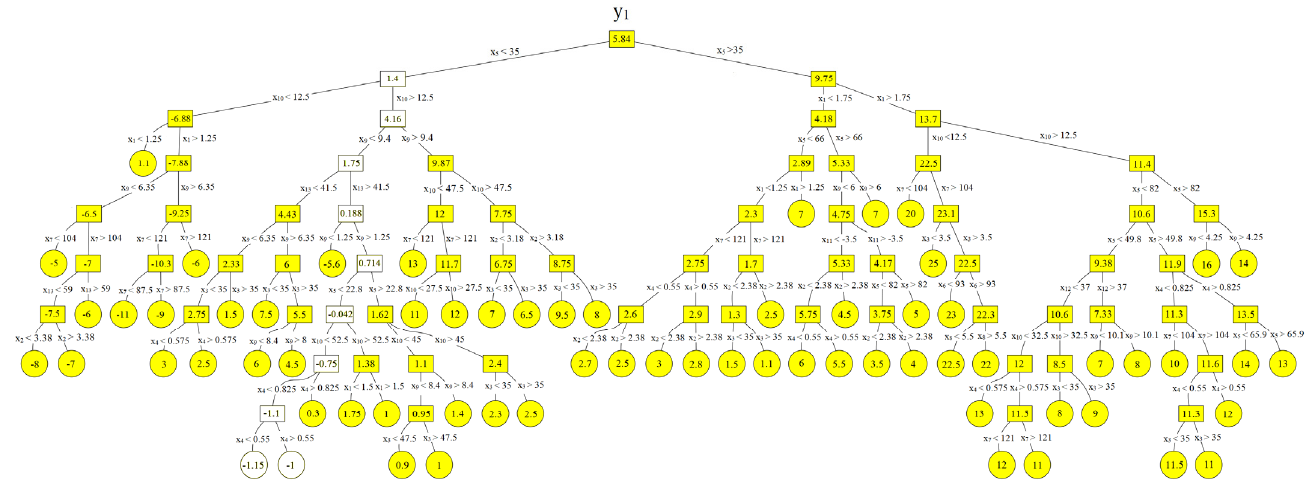
Figure 5. Regression tree analyzing the dependence of the solid–liquid interface deflection y 1 (mm) on the furnace design and process parameters x 1 –x 13 . The white-marked branches where leaf nodes have a mean deflection y 1 ≤ 0 mm, i.e., a slightly convex shape of s/l interface, are favorable. The RMSE for each split is given in Table A2 in Appendix A. Table 2. The most decisive inputs and their optimal values for the Cz-Ge growth with flat or slightly convex s/l interface (y 1 ≤ 0 mm), derived from RT analysis. The data ranges correspond to the white nodes in Figure 5.